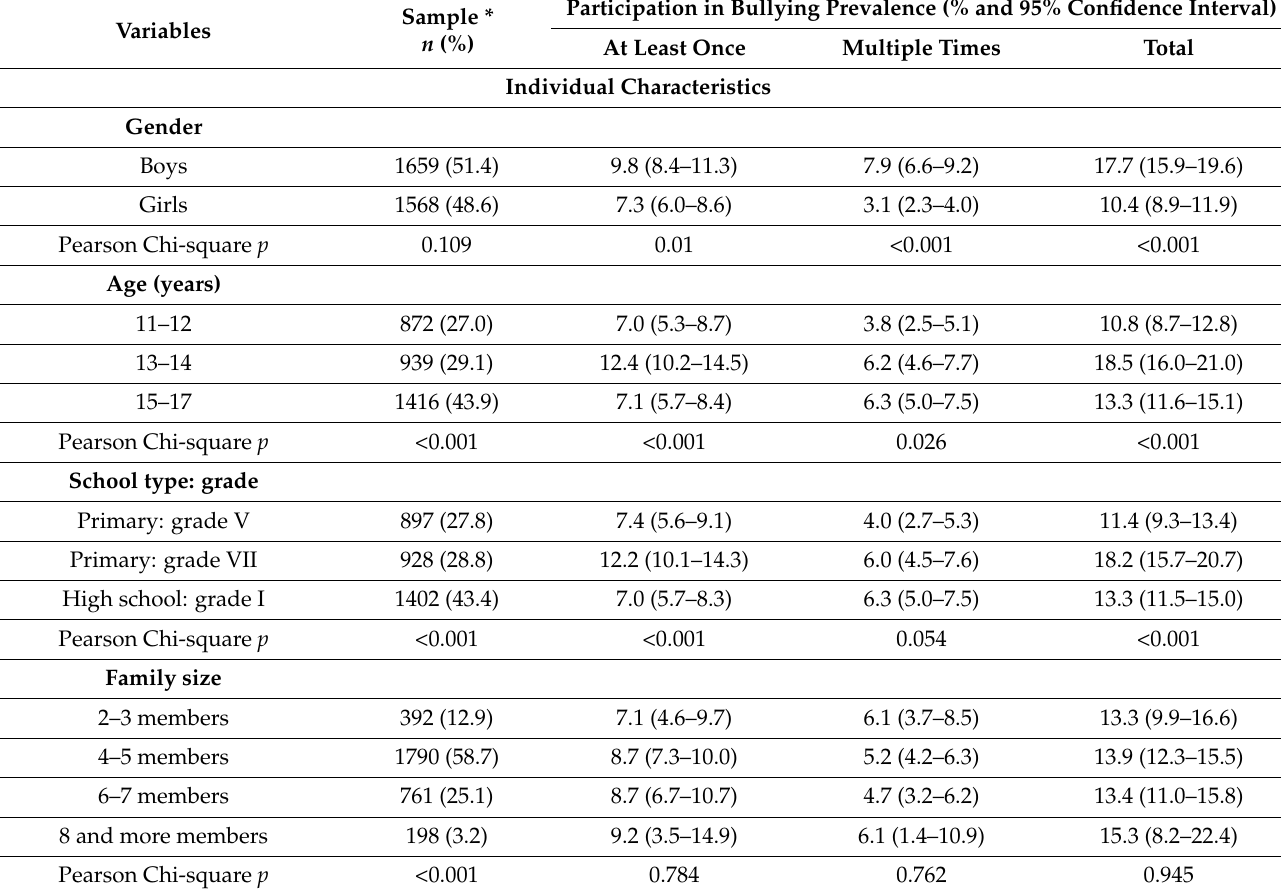
Table 2. Prevalence of participation in bullying among school-age children in Serbia,